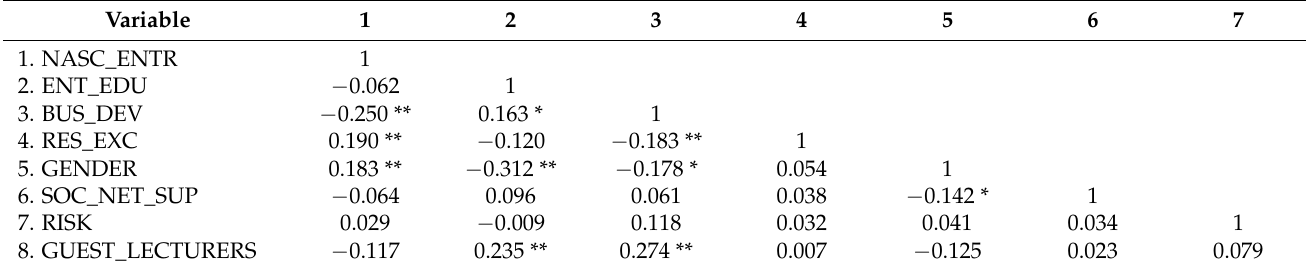
Table 3. Correlation matrix.